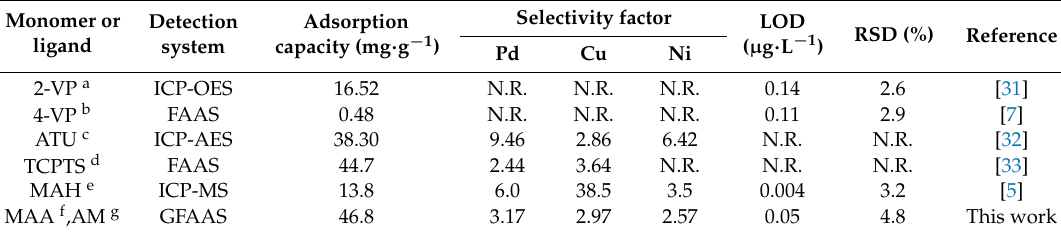
Table 3. Comparison of analytical performance of different cadmium(II)-imprinted polymers used for SPE